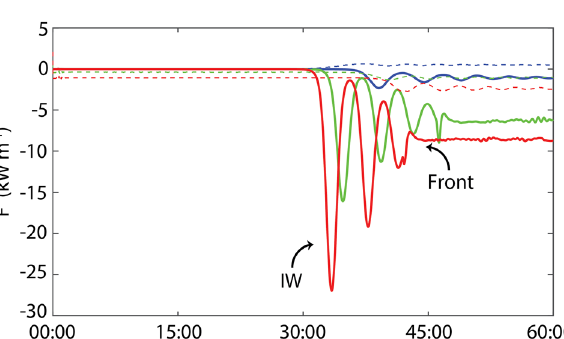
Figure 5. Energy fluxes. Simulated seaward (solid) and landward (dashed) depth-integrated perturbation energy fluxes F ′ at x = − 500 m for different numerical simulations. The curves represent the numerical results using the parameters listed in Table 1. Red, run #1; green, run #2; blue, run